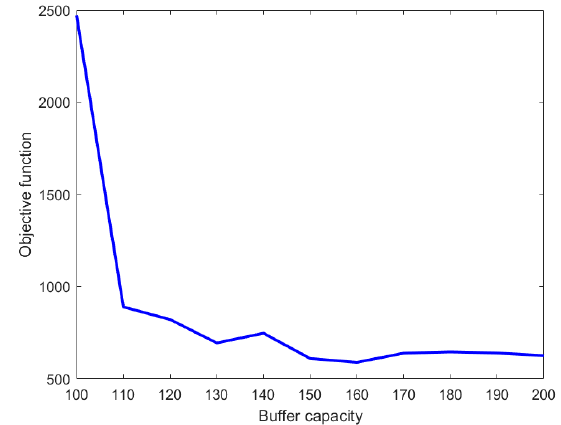
Figure 3. Impact of the buffer capacity on the objective function.